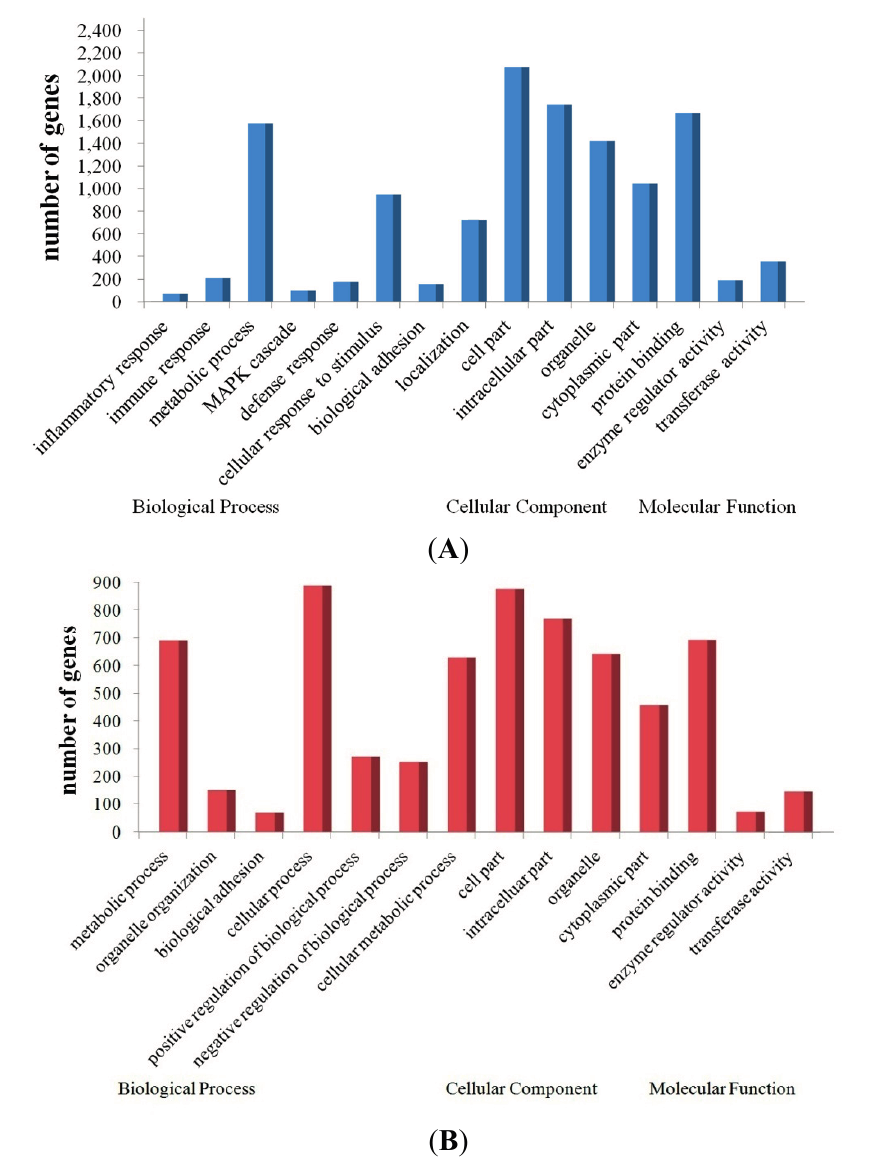
Figure 5. GO annotation of the predicted miRNA target genes. The figure shows the GO annotation of the upregulated genes ( A ) and downregulated genes ( B ) in biological processes, cellular components and molecular